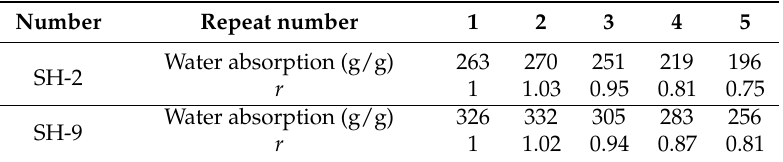
Table 2. The repetitive absorption of the